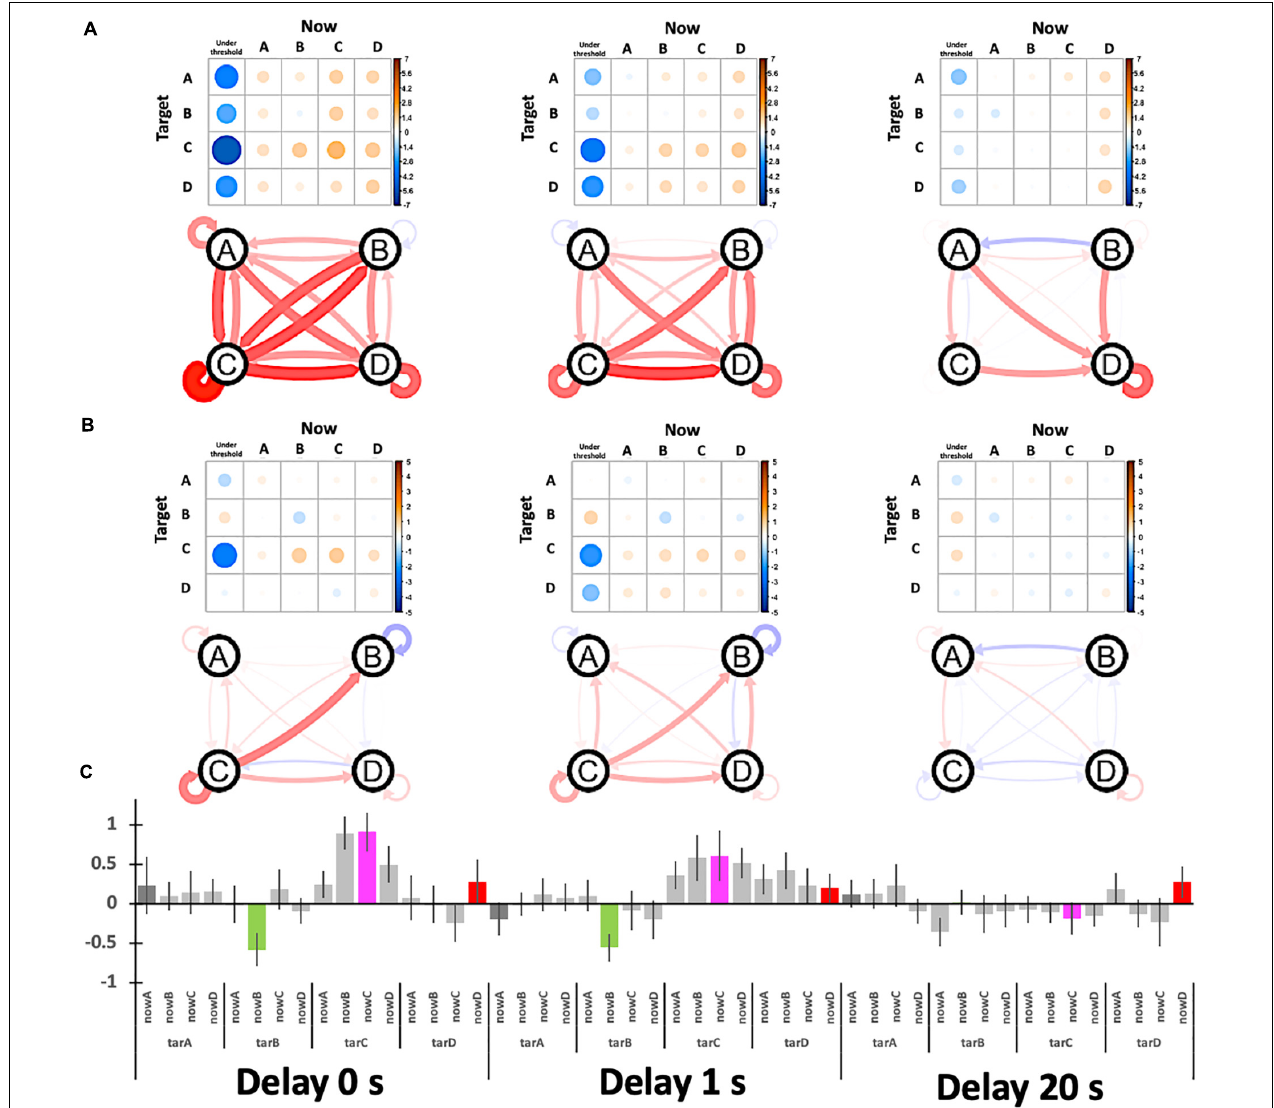
FIGURE 9 | Participants’ relative performance for target specificity. (A) The baseline is the no-target period (“task-ready”) under the no-delay condition. (B) The baseline is the session average (the column-means for “task-general”) for each delay condition. The graphs show the relative Hits (self-recursive arrows for target specificity) and Misses (other arrows) where the nodes (A, B, C, and D) indicate the target. (C) The bar plot summarizes (B) with ± 1 S.E. error